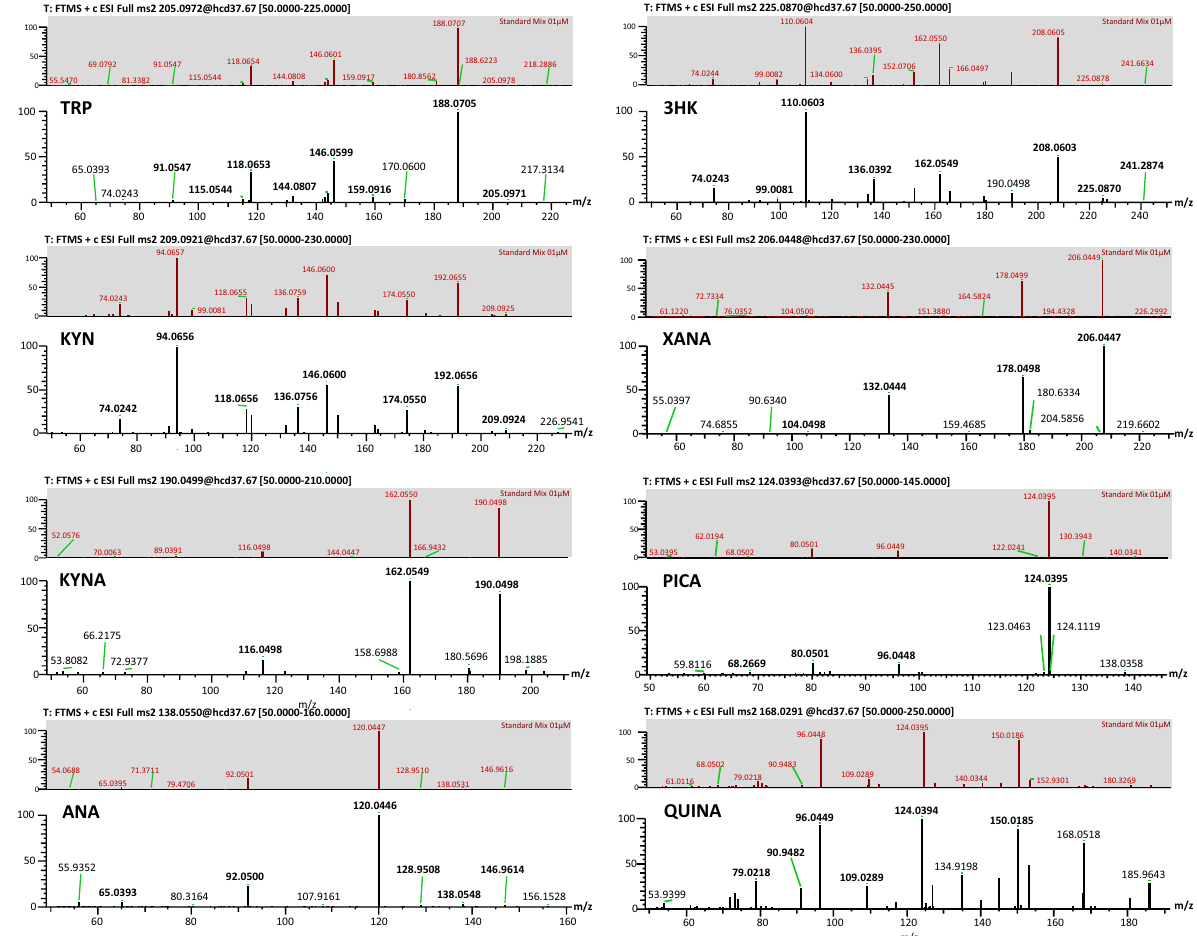
Figure 7. M 2 mass spectra in positive ion mode for Tryptophan (Trp), kynurenine (KYN), kynurenic acid (KYNA), anthranilic acid (ANA), 3-hydroxy-kynurenine (3HK), xanthurenic acid (XANA), picolinic acid (PICA), and quinolinic acid (QUINA) in hemolymph compared with the corresponding M 2 spectra of the standard mix (0.01